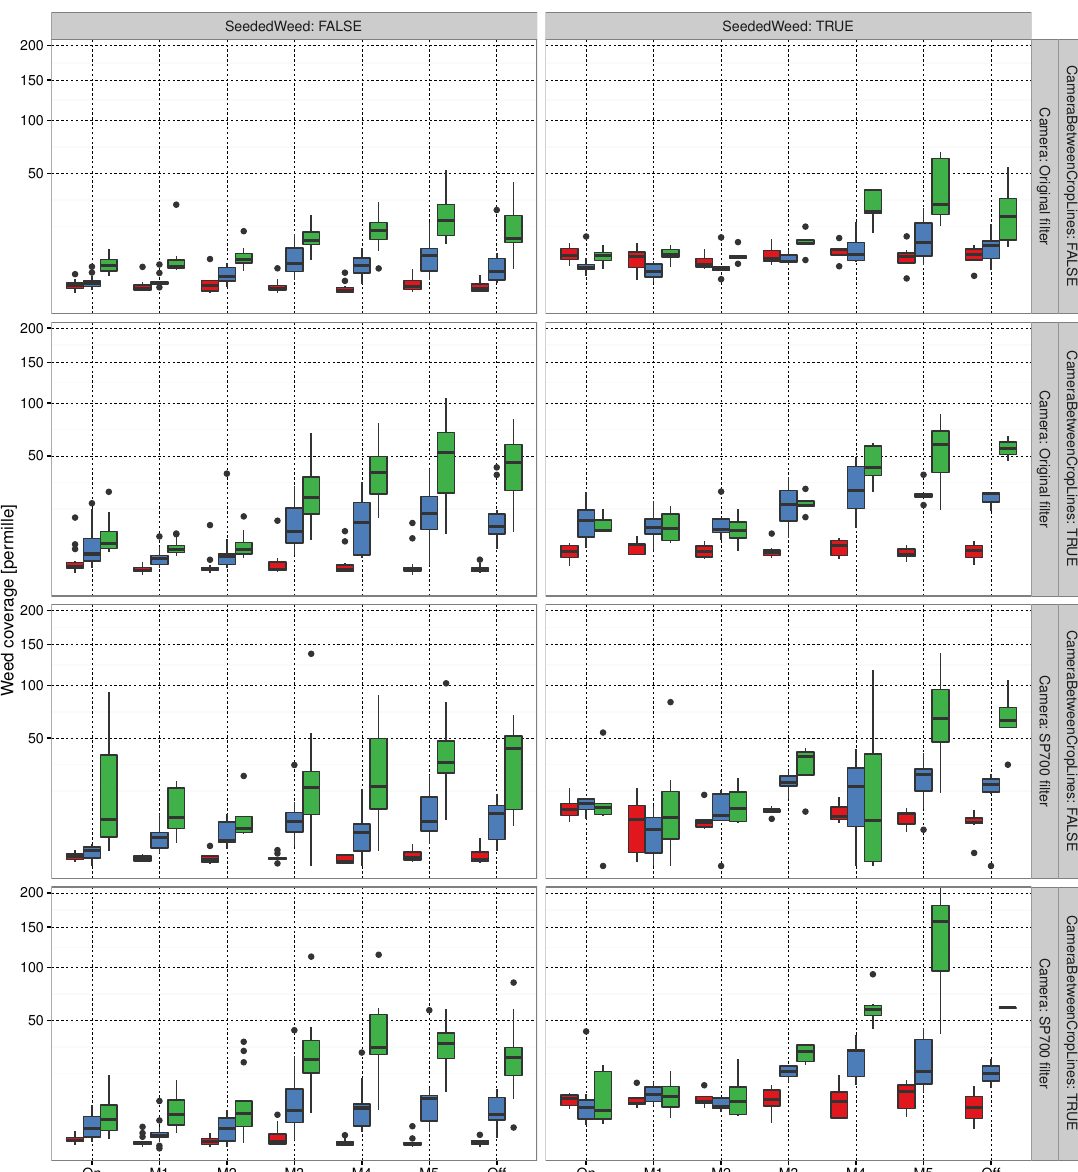
Figure 10. Weed density estimate for each of the three instances of image acquisition in the field. The first scan session is marked in red, the second in blue, and the third in